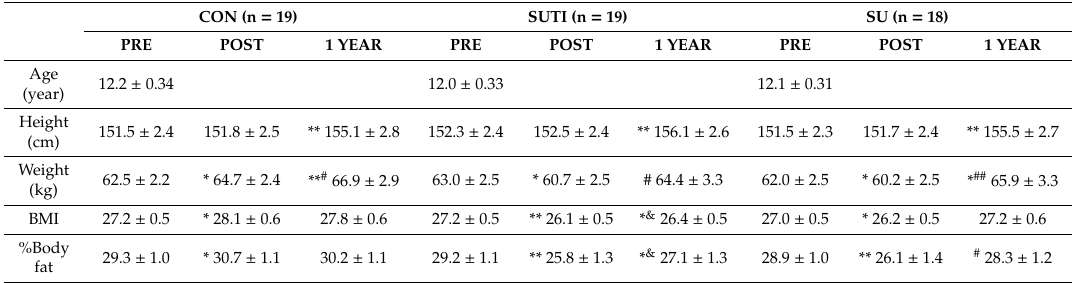
Table 1. Physical characteristics of subjects at baseline (PRE), after 8 week summer camp (POST), and after 10 month follow-up (1YEAR).